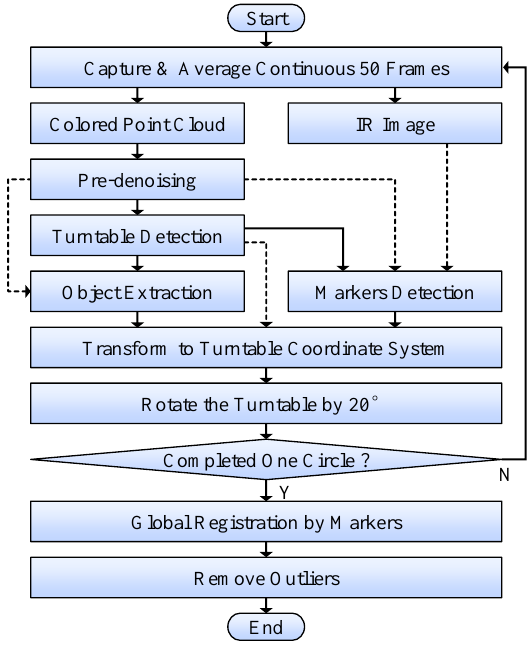
Figure 2. Data acquisition procedure of our system. Solid lines are the main processes and dashed lines represent to use the information/data obtained by previous steps.